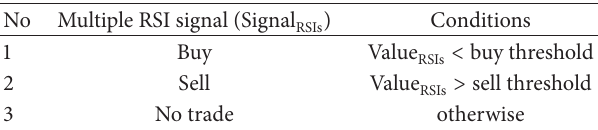
Table 4: Conditions that need to be satisfied before issuing the RSI signal.